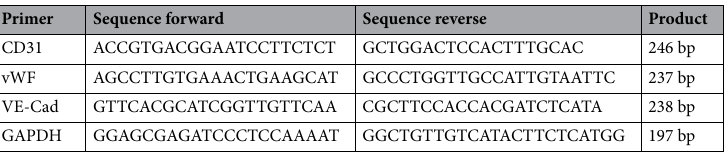
Table 2. Primers used for PCR. Sequences were obtained from PrimerBank 46